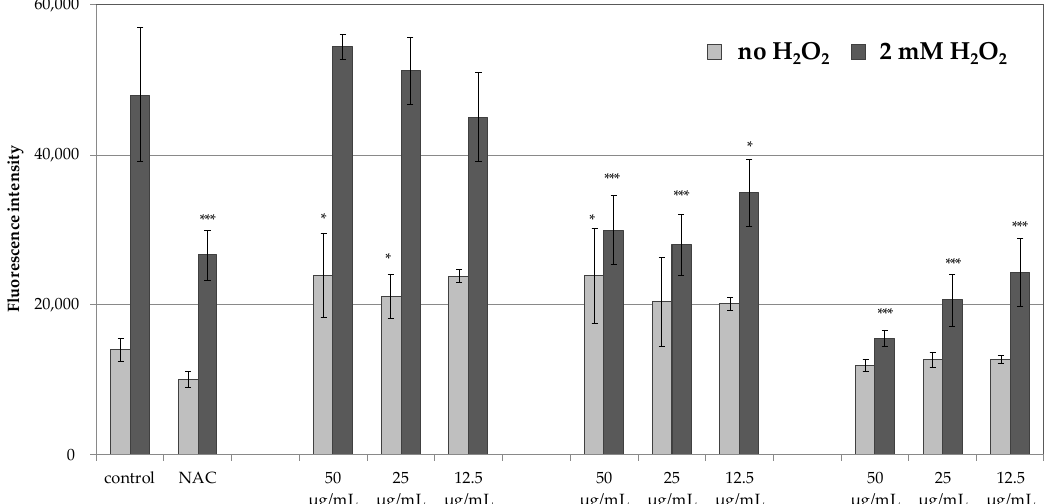
Figure 3. Mean fluorescence intensity values of H 2 DCFDA-loaded HaCaT keratinocytes treated with 50 µ g/mL, 25 µ g/mL or 12.5 µ g/mL PHT-MLT, SNT-MLT, and vitamin C or 2 mM NAC as an antioxidant control, with or without the stimu- lation with 2 mM H 2 O 2 ; increasing fluorescence intensity indicate high levels of intracellular ROS; graph presents mean fluorescence intensity for 180 min time point; the data on graphs show mean values ± SD that are representative for three experiments; n = 4 , *** p < 0.001, * p < 0.05.